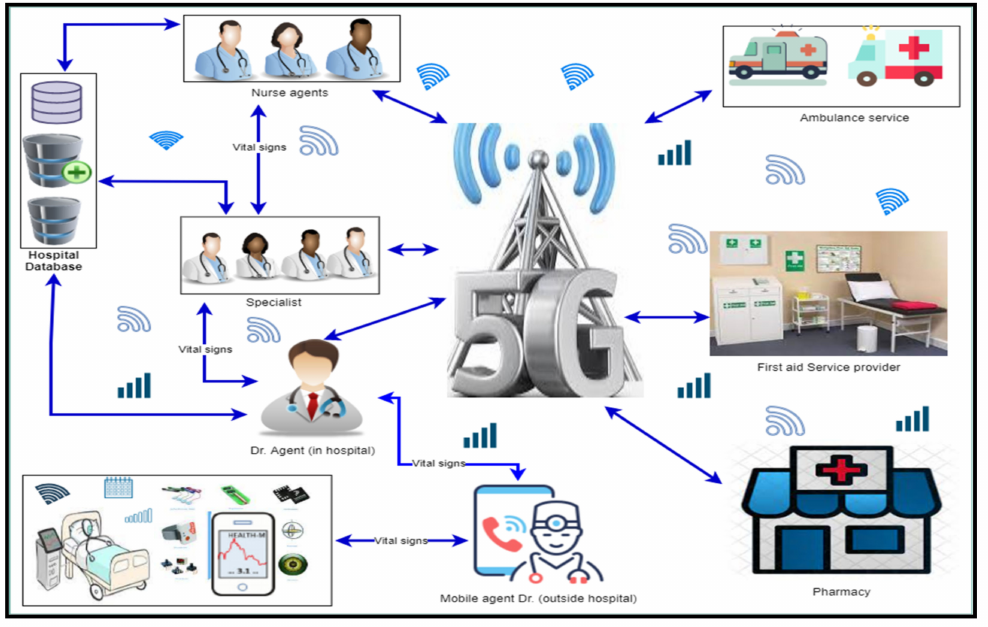
Figure 2. Proposed Framework